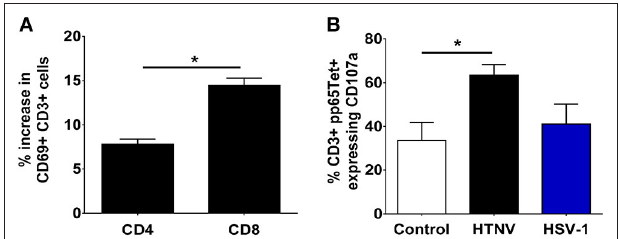
FIGURE 7 | Monocyte-dependent bystander activation of CD8 + T lymphocytes by hantavirus. PBMCs isolated from blood of healthy human donors were mock-infected or infected with HTNV. After 3–4 days cells were analyzed by flow cytometry. (A) HTNV-specific increase in CD69 + cells in the CD4 + and CD8 + subset of CD3 + cells after 4 days of incubation. Results are from three independent experiments. Error bars represent the mean ± SEM (* p < 0.05, paired Student’s t- test). (B) PBMCs from HLA-A2 + HCMV-seropositive healthy human donors were exposed to HTNV or HSV-1 for 4 days before being stained for HCMV-specific CD3 + cells using a pp65 loaded tetramer reagent (CMVpp65TET). Degranulation was determined by CD107a staining. Results are derived from three independent experiments. Error bars represent the mean ± SEM (* p < 0.05, paired Student’s t-